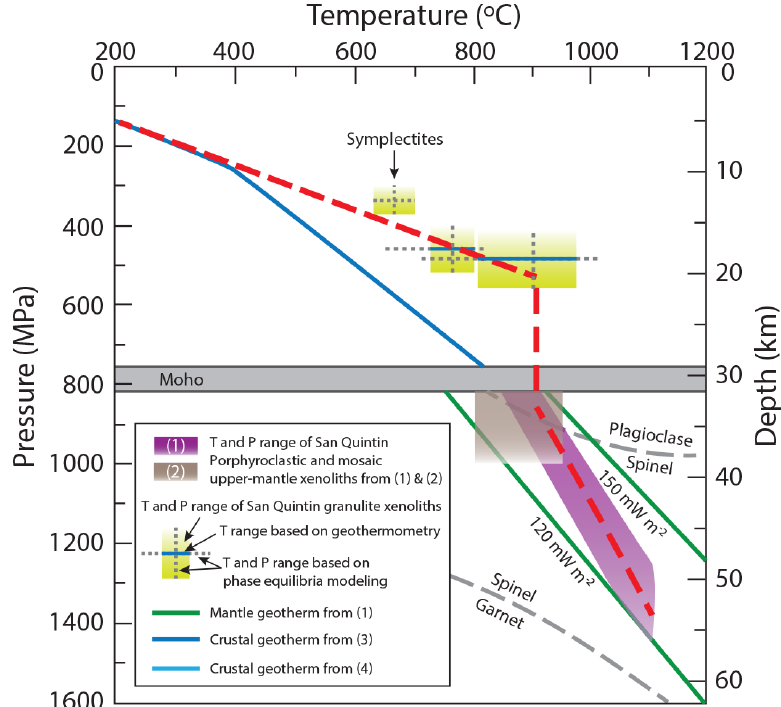
Figure 12. Estimated temperatures and pressures for the San Quintín xenoliths. The conditions for the lower-crustal xenoliths are from this study. The conditions for the upper-mantle xenoliths are from (1) Luhr and Aranda-Gómez (1997) and (2) Cabanes and Mercier (1988). Crustal geotherms are from (3) Rothstein and Manning (2003) and (4) Negrete-Aranda et al. (2013). Mantle geotherms are from (1) Luhr and Aranda-Gómez (1997) for surface heat flows of 120 and 150mWm − 2 . The red line describes the inferred geotherm for the P – T conditions in the San Quintín lower-crustal and upper-mantle